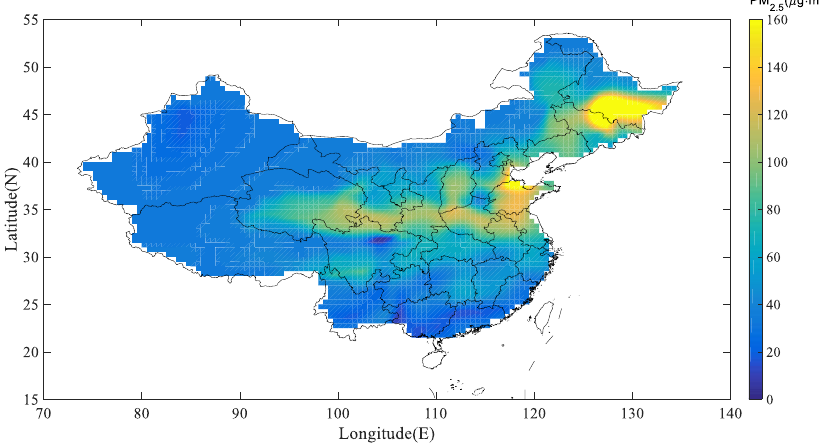
Figure 10. Mean distribution of the simulated PM 2.5 on November 8–11, 2014 obtained after adding observations.